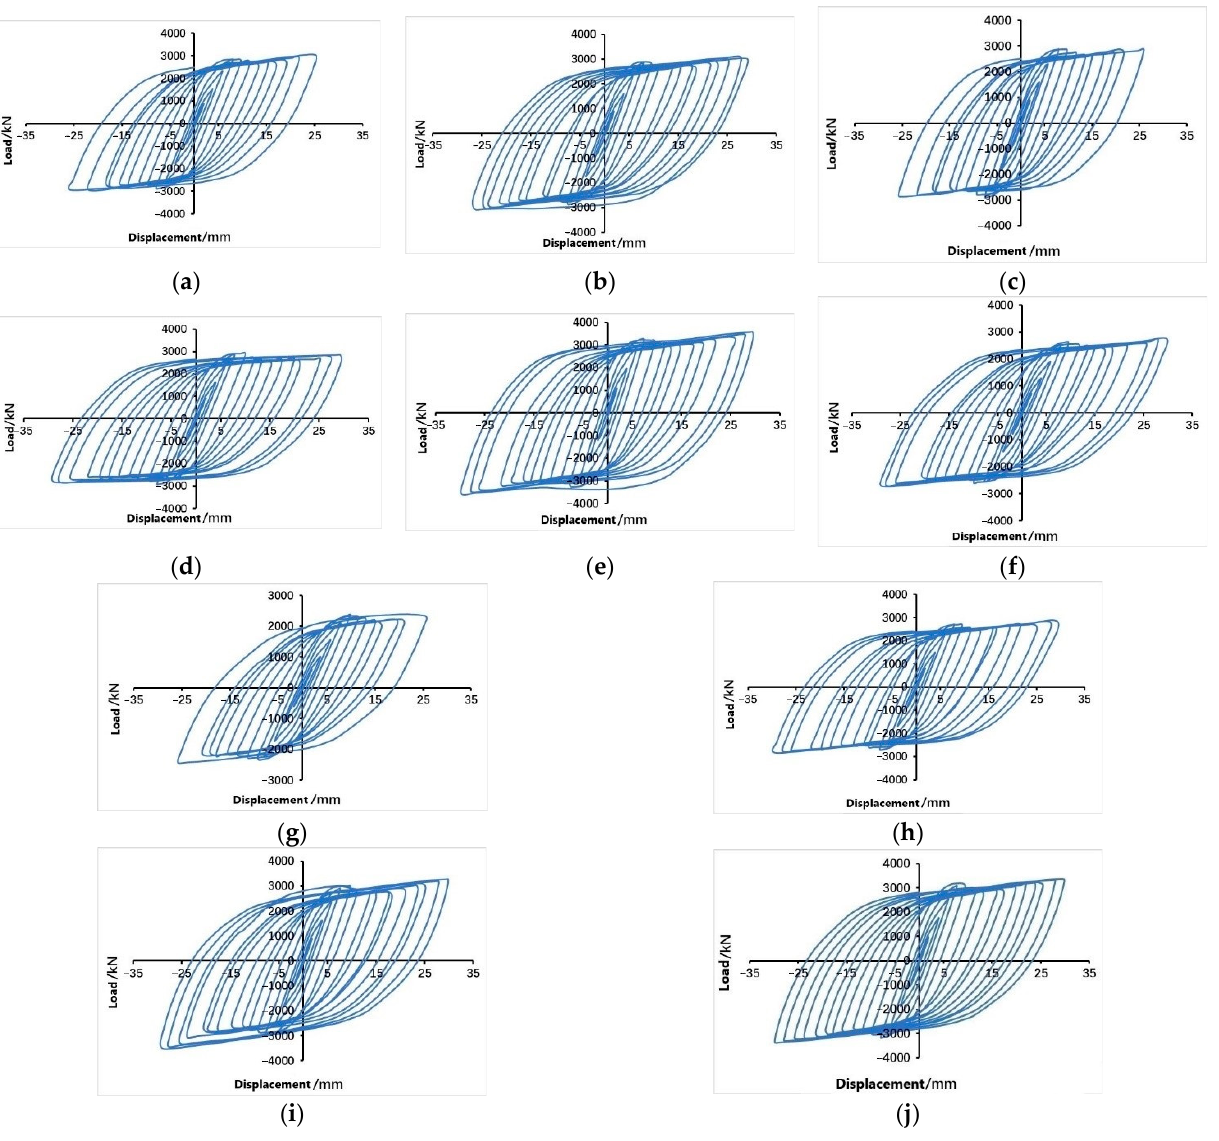
Figure 16. The hysteresis curves of different parameter models. ( a ) SPRC-1. ( b ) SPRC-2. ( c ) SPRC-3. ( d ) SPRC-4. ( e ) SPRC-5. ( f ) SPRC-6. ( g ) SPRC-7. ( h ) SPRC-8. ( i ) SPRC-9. ( j ) SPRC-10.